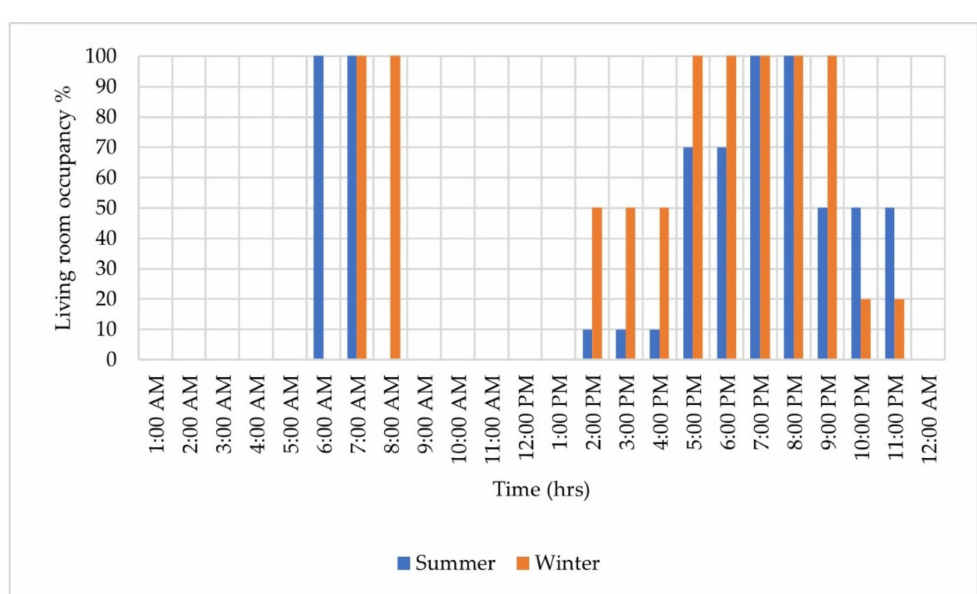
Figure A2. Living room occupancy